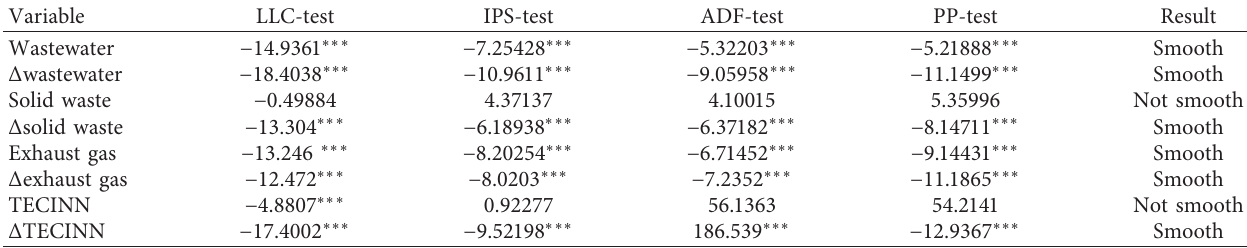
Table 3: Results of unit root test.